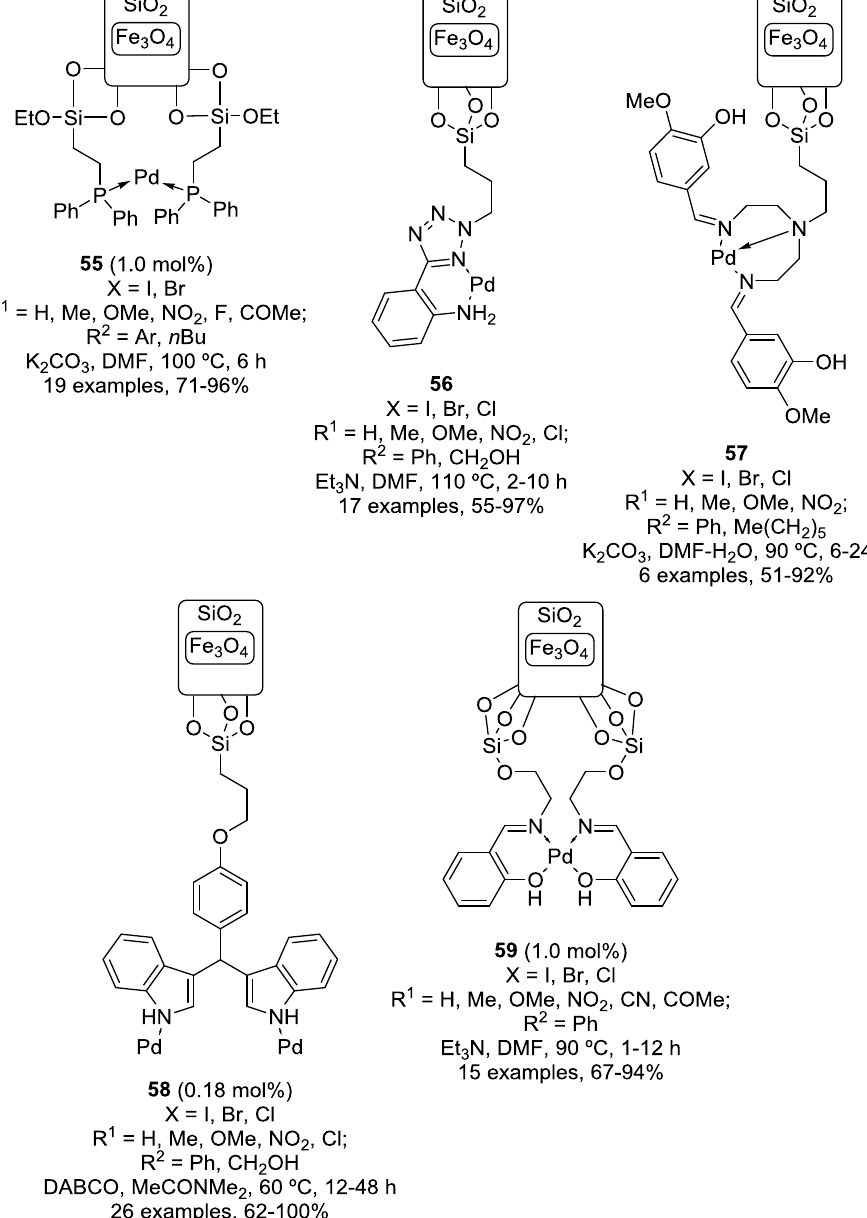
Figure 18. Magnetite-Silica coated-grafted palladium catalysts for the Sonogashira reaction. Conditions, substrate scope and yield range (Scheme 2).